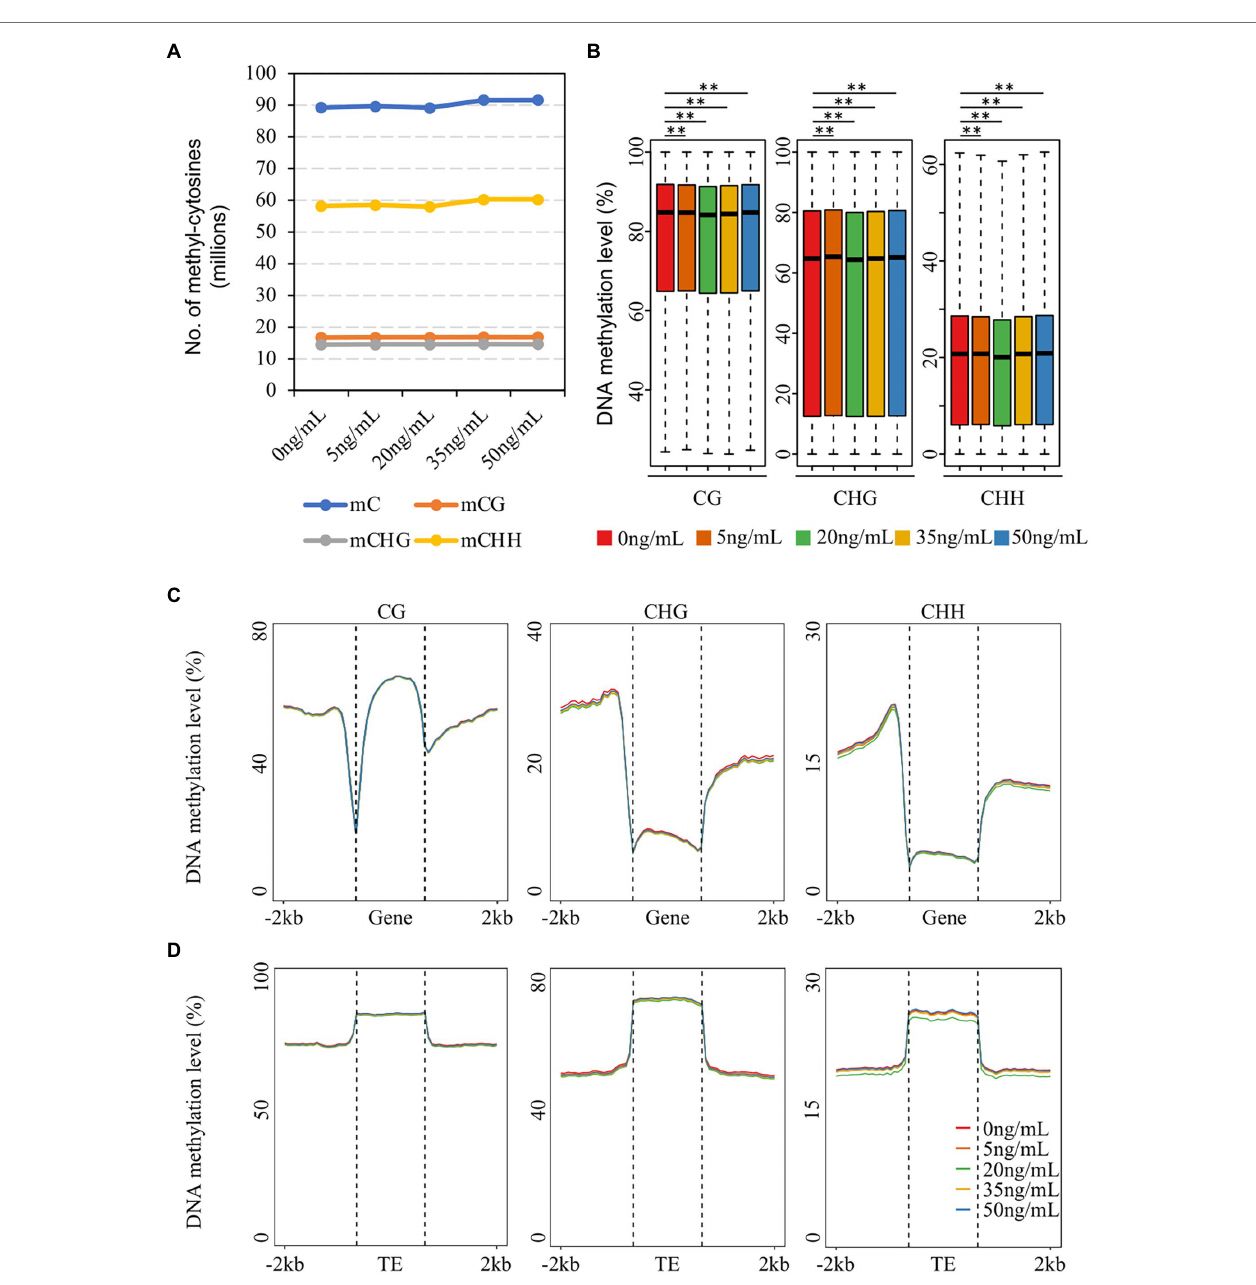
FIGURE 1 | Characteristics and comparison of DNA methylation of potato treated with different DON concentrations. (A) The number of methyl-cytosine of CG, CHG and CHH context of each sample. (B) Distribution of methylation levels in 200 bp windows after five DON concentration treatments (Mann–Whitney test p < 0.001). (C,D) Metaplot showing CG, CHG, and CHH methylation levels and patterns of gene (C) and TE (D) regions after different DON concentration